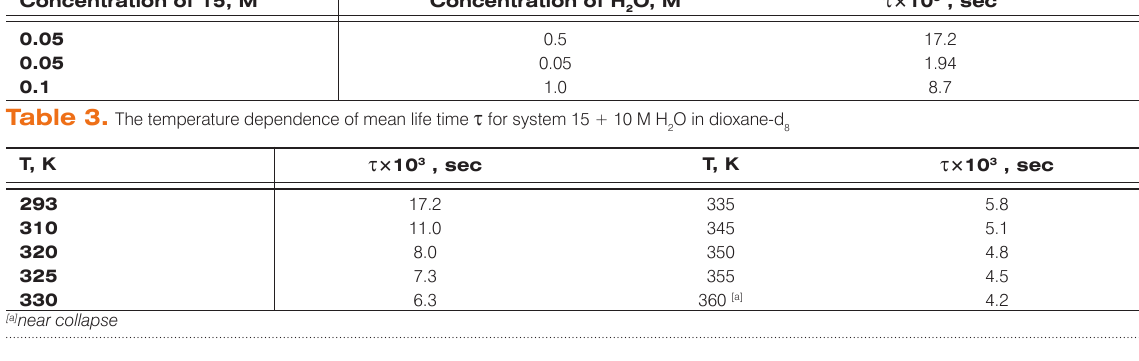
Figure 7. 1 H spectrum of 15 at -50 o Table 2. The concentration dependence of mean life time τ for system 15 + H Concentration of 15, M